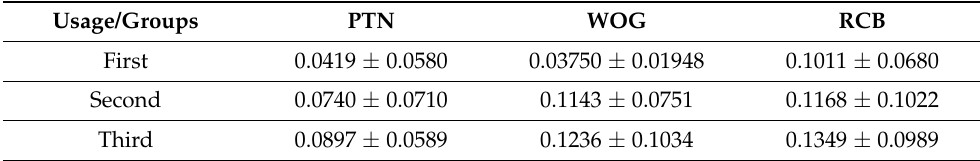
Table 3. Measurements for at 5 mm from apical (mean ±